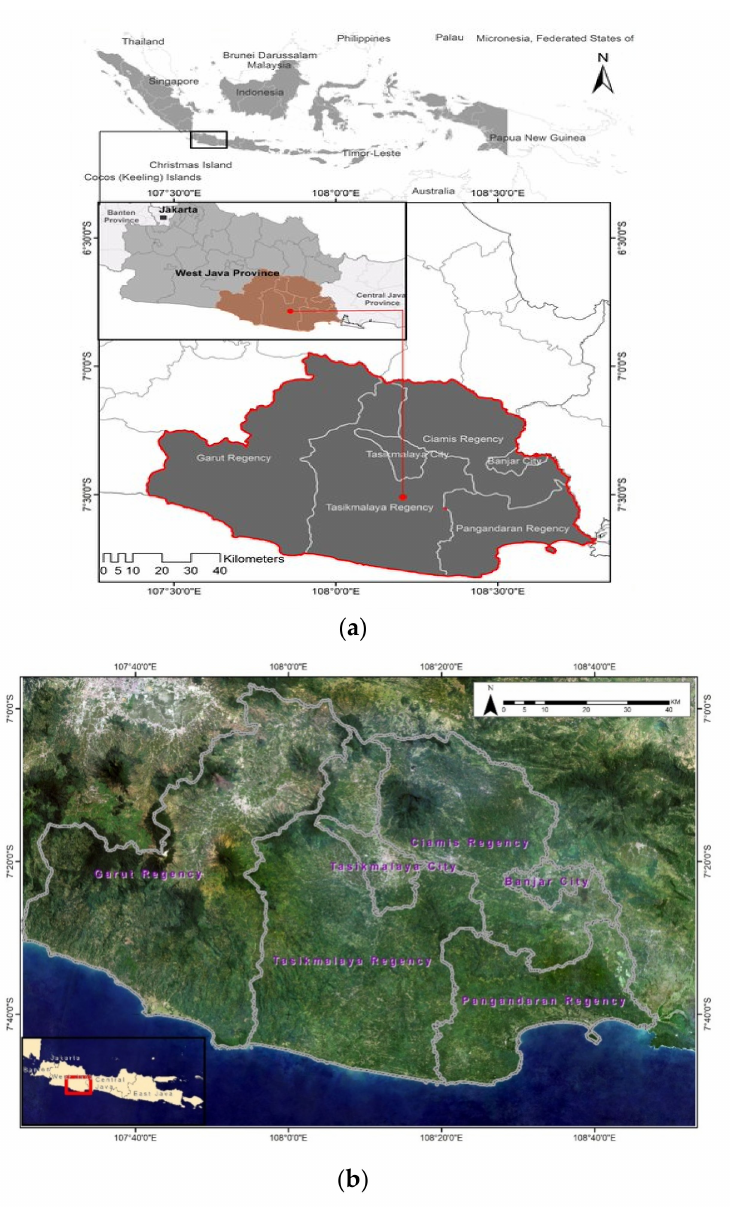
Figure 1. Locations of study sites in West Java ( a ), Landsat 8 imagery (2020) of study sites ( b ). The five districts had a total area of 8850 km 2 and a human population of 6,198,824 in 2020, and therefore a high population density of 700 inhabitants per km 2 [36]. The climate is equatorial with two distinct seasons: dry from April to October, and rainy